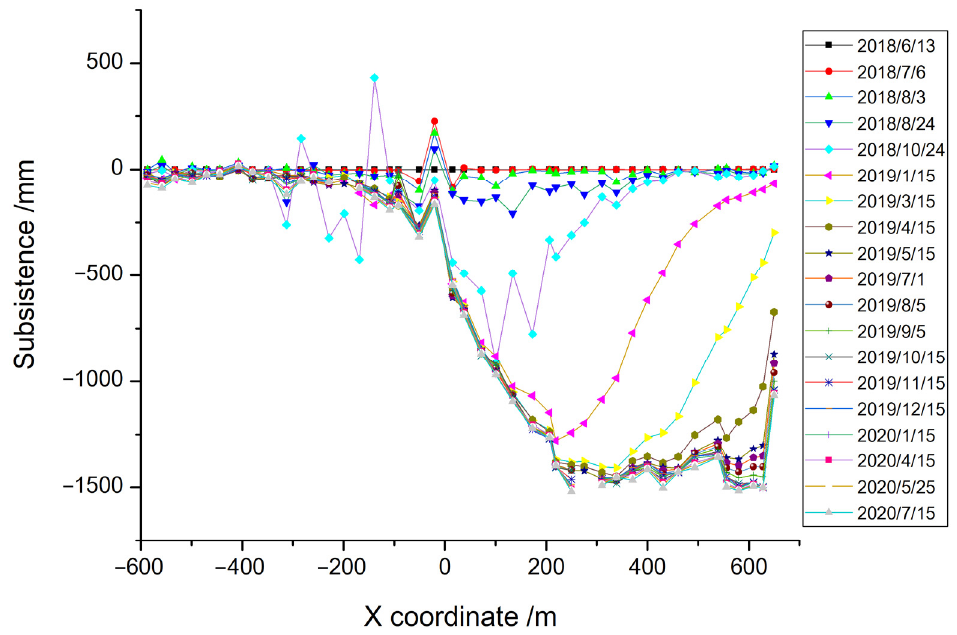
Figure 4. The subsidence curves along the strike section at each phase.